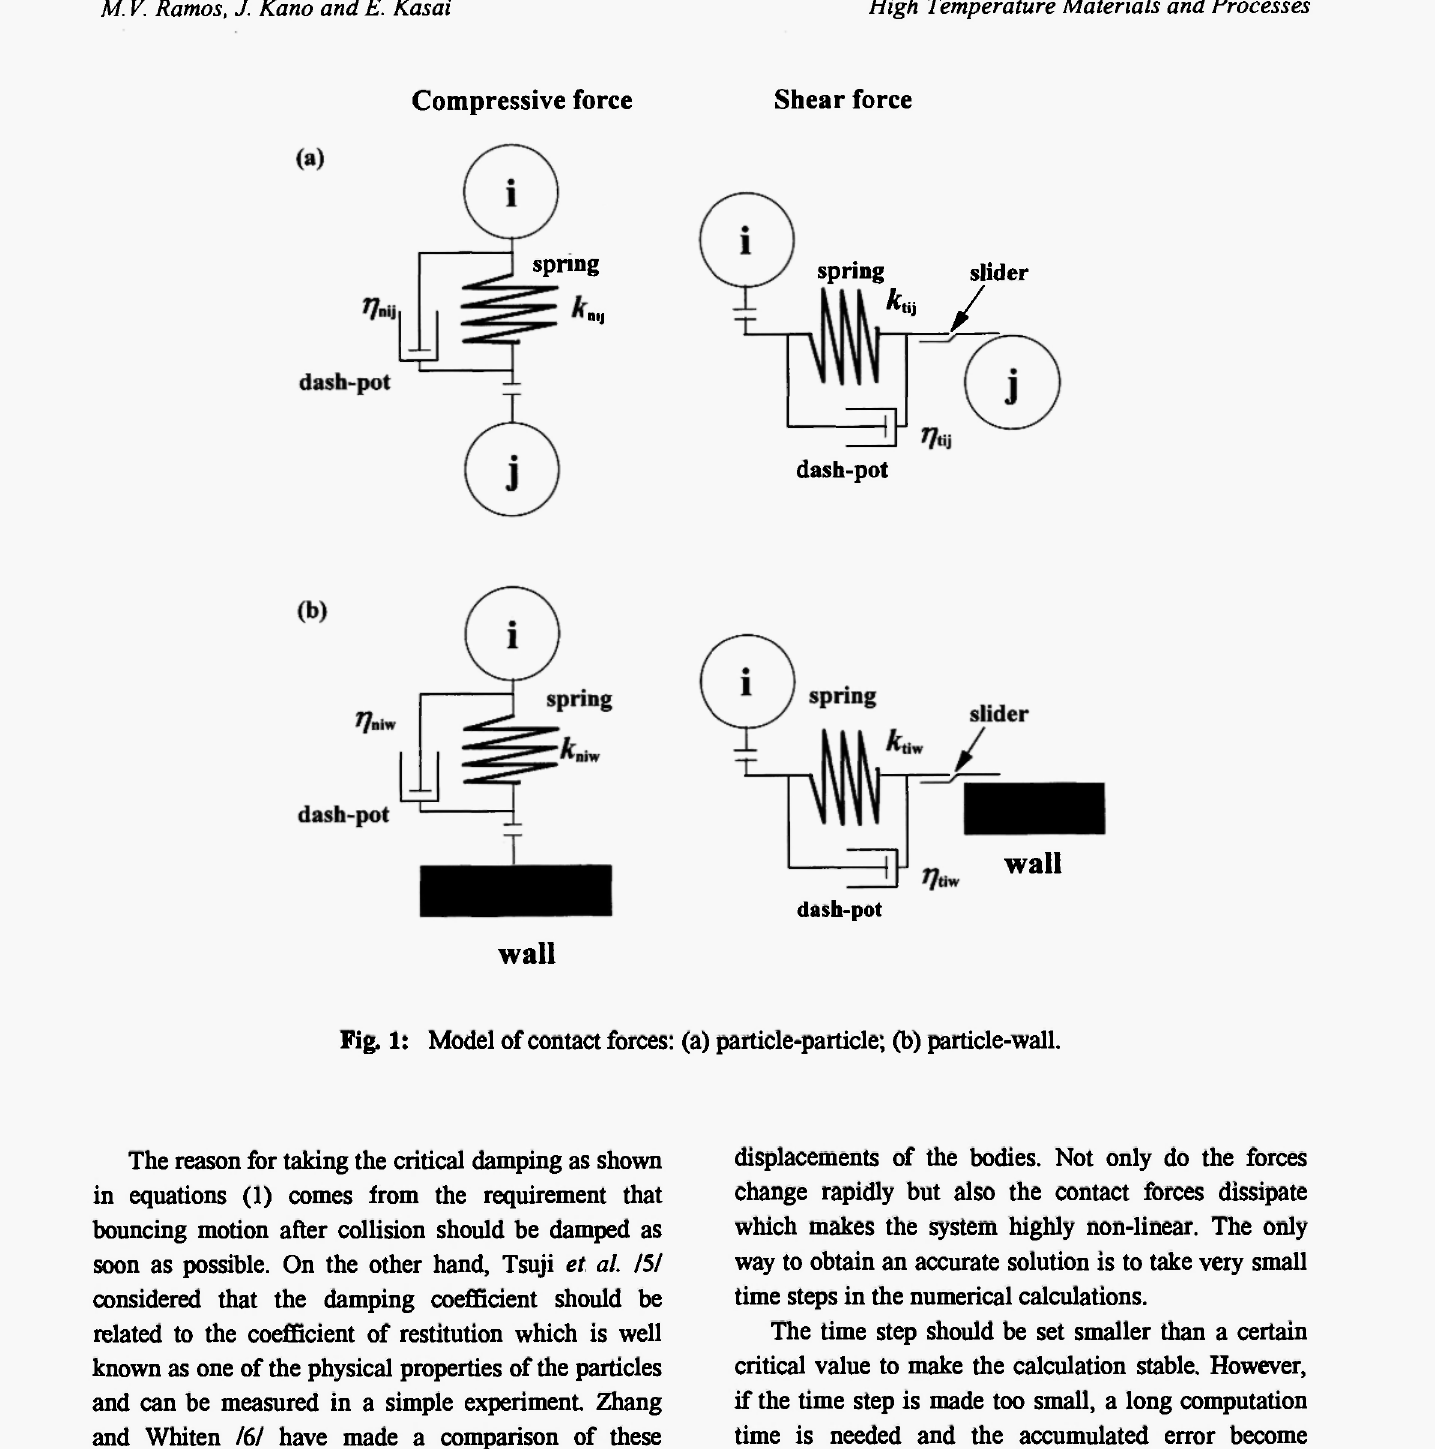
Fig. 1: Model of contact forces: (a) particle-particle; (b)